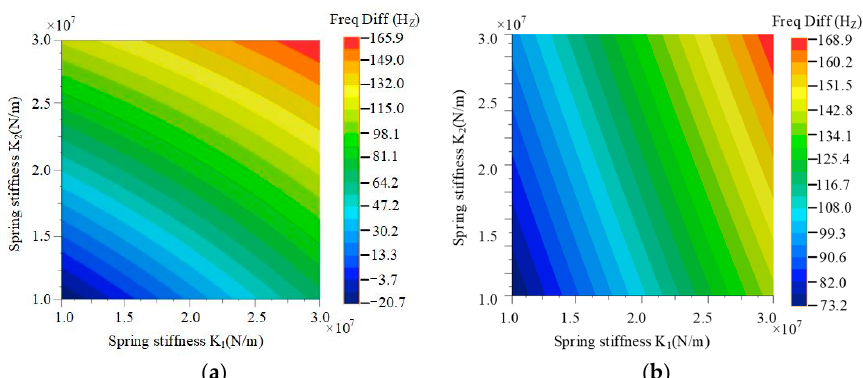
Figure 8. Variation trend of frequency difference with different spring stiffness. ( a ) The first mode. ( b ) The fifth mode.